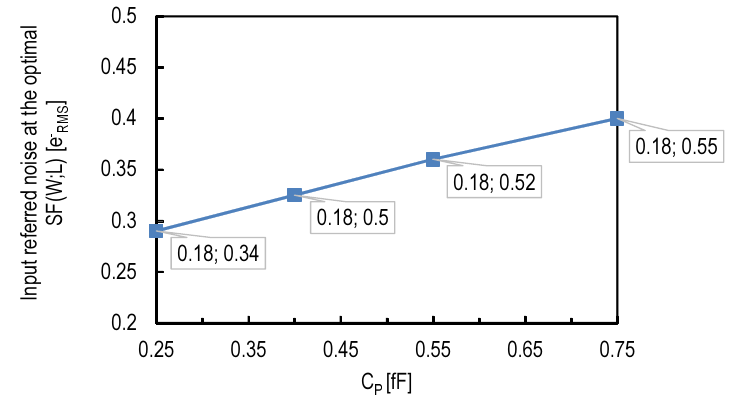
Figure 14. The input-referred 1/ f noise as a function of the capacitance C P determined by the floating diffusion, wiring and parasitic capacitances independent from the source follower transistor. C P = 0.75 fF corresponds to the case of a conventional sense node junction, transfer gate and transistors. C P = 0.55 fF corresponds to the case of transfer and reset gates without low doped drains [30]. C P = 0.4 fF corresponds to the case of transfer and reset gates without low doped drains and a sense node without channel stop underneath [30]. C P = 0.25 fF corresponds to the case of more advanced process refinements as [7,30]. The numbers in labels correspond to the minimum width and optimum length as discussed in Section